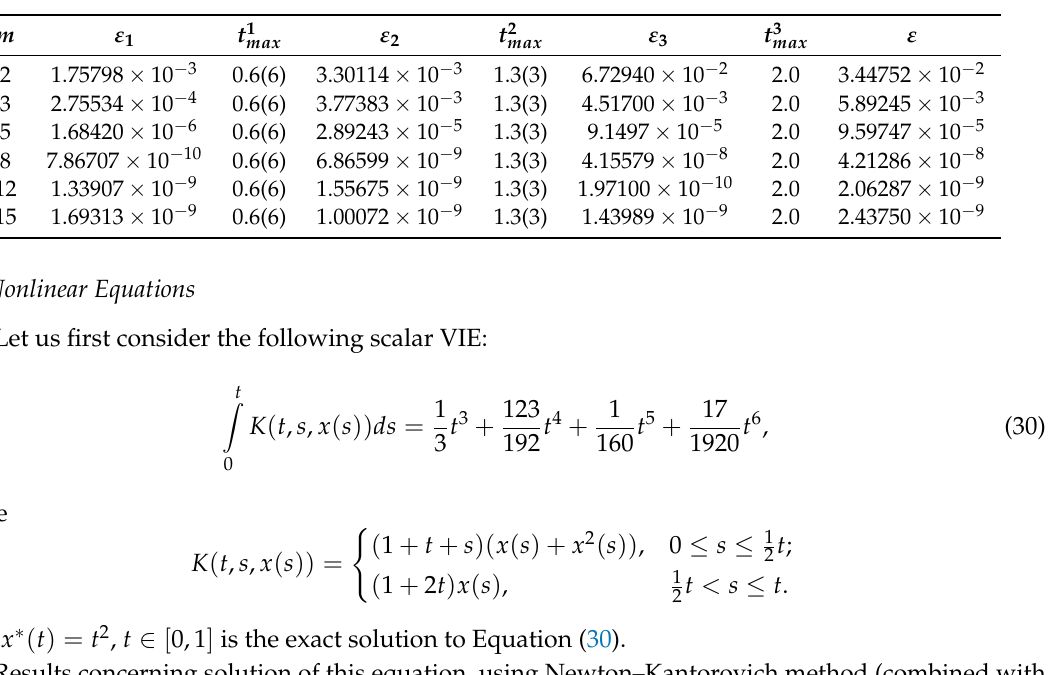
Table 2. Results for problem (29).